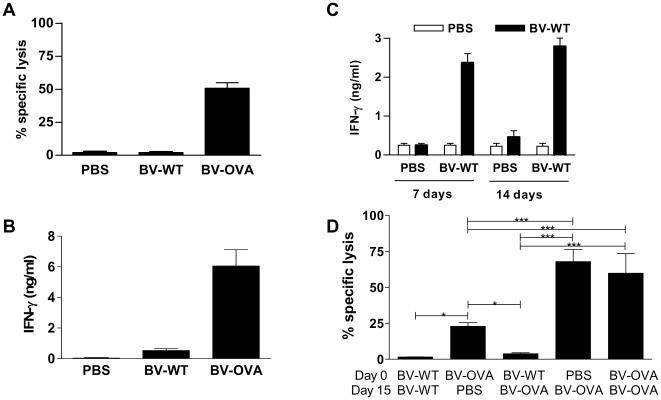
Anti-OVA CTL response in mice injected with BV-OVA is long-lasting and not affected by repeated immunization with the same vector.(A, B) C57BL/6 mice were immunized by a single i.v. injection of 5×107 PFU BV-WT, BV-OVA or PBS. One hundred and ten days later, immunized mice received an i.v. injection of a mixture (1∶1) of OVA256-264 peptide-loaded CFSEhigh and unloaded CFSElow splenocytes. Twenty hours later, spleen cells were recovered to determine (A) the percentage of specific in vivo killing by flow cytometry and (B) IFN-γ content by ELISA in supernatants of spleen cells from immunized mice, cultured for 48 hours in the presence of OVA protein. (C) C57BL/6 mice were immunized by a single i.v. injection of 5×107 PFU BV-WT or PBS. Seven and fourteen days later, spleen cells were recovered and cultured with BV-WT (MOI 5) for 48 hours. The IFN-γ content in supernatants was determined by ELISA (D) C57BL/6 mice were immunized by a single i.v. injection of 5×107 PFU BV-WT, BV-OVA or PBS. Fifteen days later, mice received a second i.v. injection of 5×107 PFU BV-WT, BV-OVA or PBS, combined as shown in the figure. Seven days later, immunized mice received an i.v. injection of a mixture (1∶1) of OVA256-264 peptide-loaded CFSEhigh and unloaded CFSElow splenocytes. Twenty hours later, spleen cells were recovered and the percentage of specific in vivo killing was determined by flow cytometry. *, p<0.05; ***, p<0.001. Results are representative of at least two independent experiments and are expressed as mean +/− SEM (n = 5).